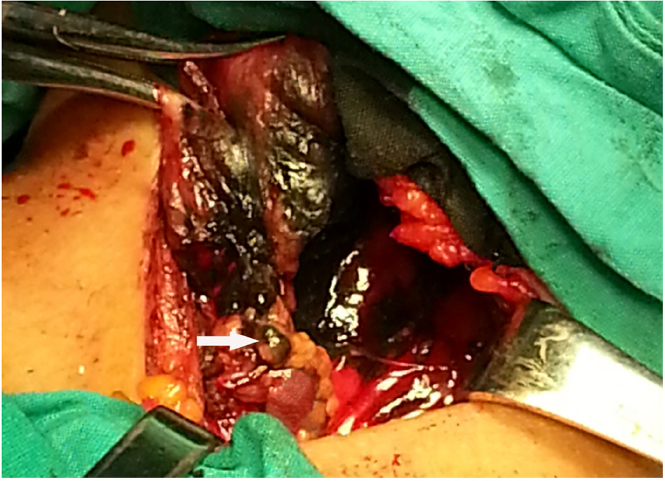
Fig 1. SLNB using CNS. The white arrow indicates the black-stained SLN in the central compartment. SLNB = sentinel lymph node biopsy; SLN = sentinel lymph node; CNS = carbon nanoparticle suspension.